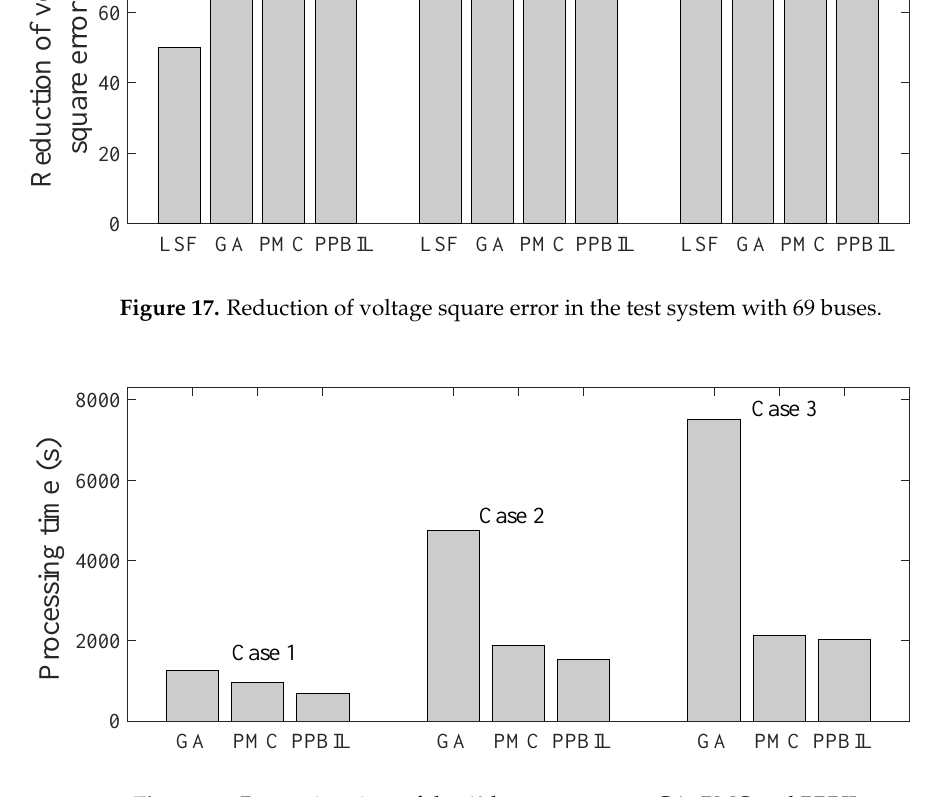
Figure 18. Processing time of the 69 bus test system: GA, PMC and